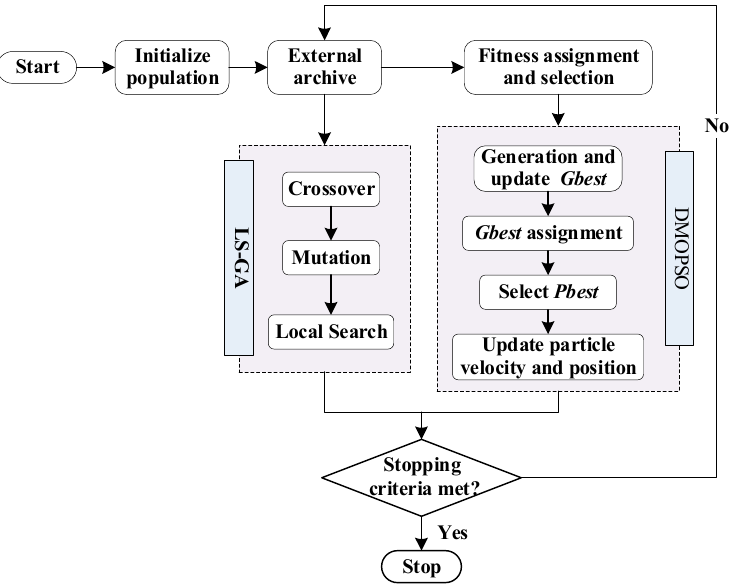
Figure 10. The flow chart of the hybrid strategy for HGA-PSO2.